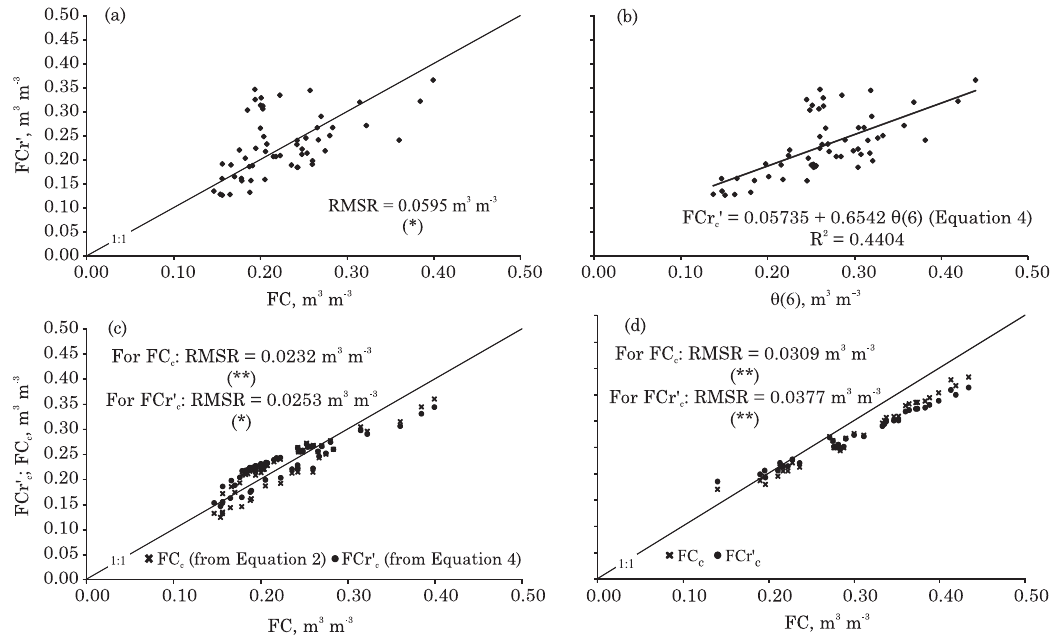
Figure 3. Relationships involving standard field capacity (FC), transformed ring field capacity (FCr’), and θθθθθ (6) data. In (a), FC is compared to FCr’. In (b), the regression equation for FCr’ vs θθθθθ (6) (Equation 4) is represented. In (c), the values calculated by equations 2 and 4 are evaluated in comparison to the FC data. The three figures are for the data set (n=56) where the ring FC information is available. In (d), the FC values predicted by equations 2 and 4 are evaluated for the samples (n=36) for which the corresponding ring FC information was not available. * and **: mean that, according to the Wilcoxon test, the variable at the vertical axis is statistically indistinguishable from FC (at p<0.01 or 0.05, respectively); **: means that the variable at the vertical axis is statistically distinguishable from FC (at p<0.01), according to the Wilcoxon